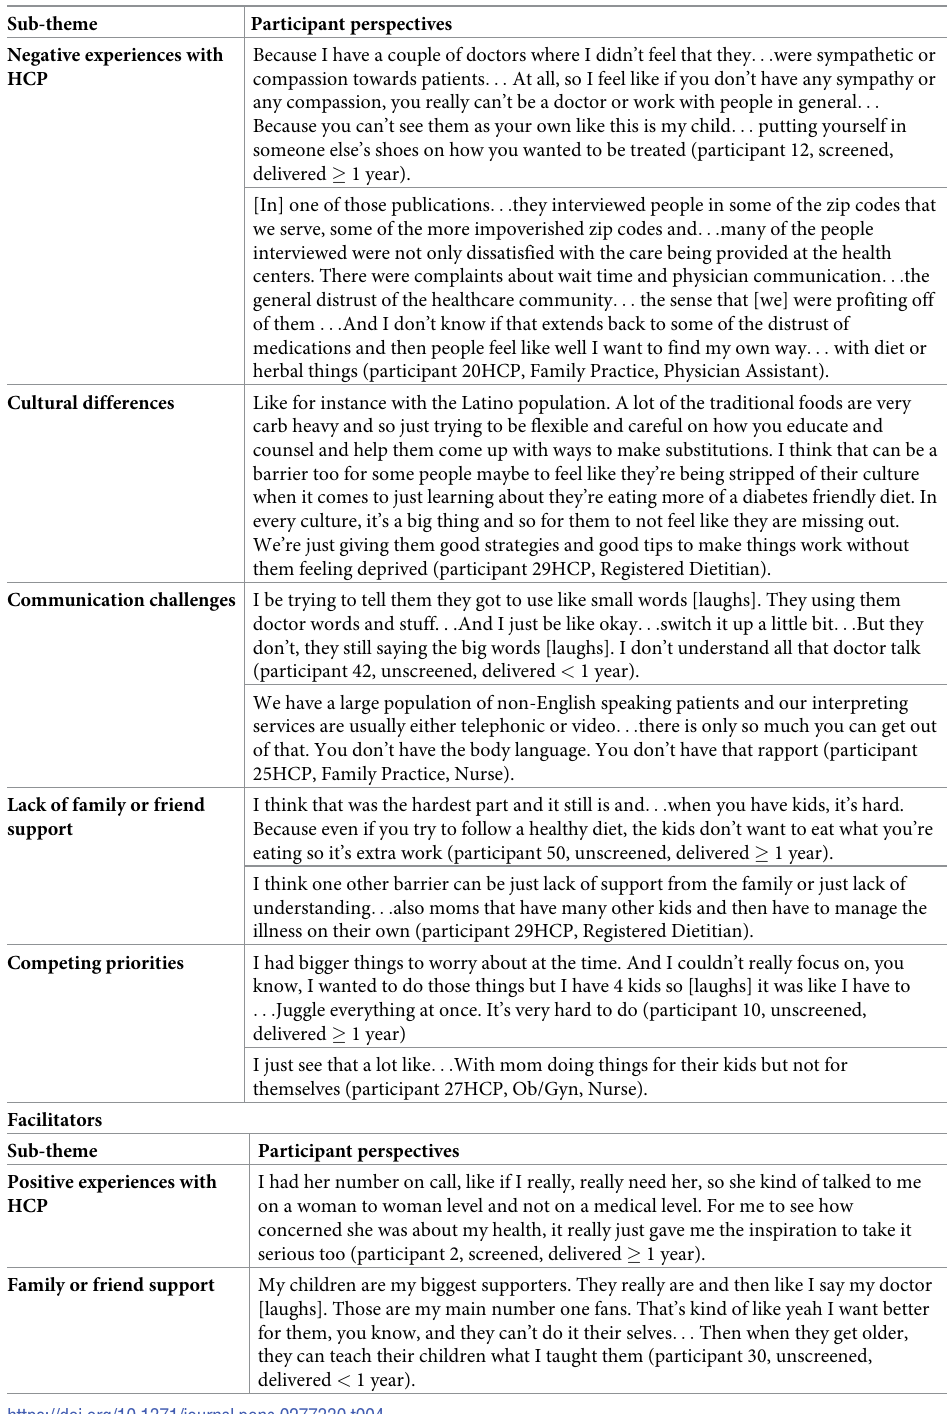
Table 4. Interpersonal level barriers and facilitators to postpartum diabetes screening and prevention: Exemplar